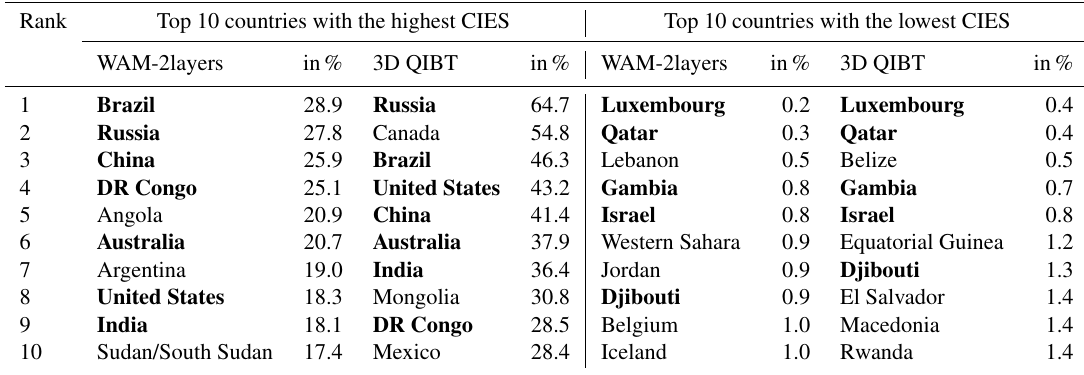
Table 6. Comparison of the top 10 countries with the highest and lowest average CIES values between our dataset based on the WAM-2layers method and the one referring to the 3D QIBT method (Dirmeyer et al., 2009). Countries appearing in both lists are displayed in bold font. Rank Top 10 countries with the highest CIES Top 10 countries with the lowest